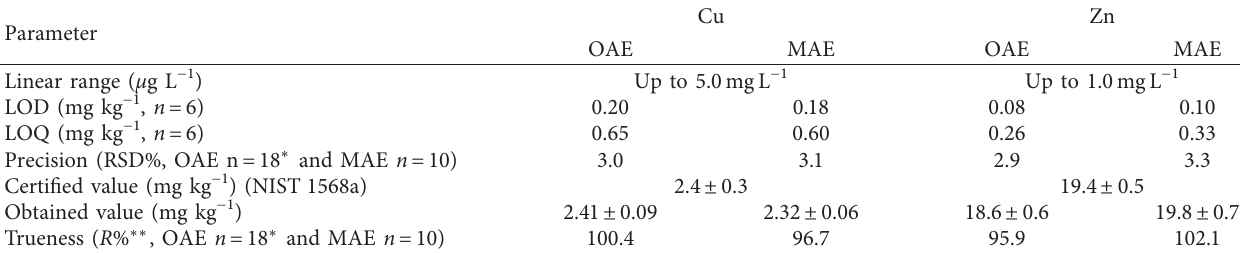
Table 1: Figures of merit for the OAE and MAE methods.